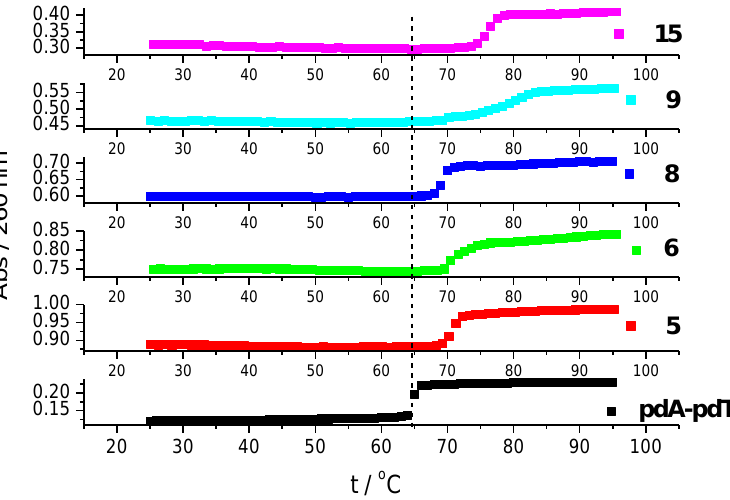
Figure 2. Melting curve of poly dA-poly dT upon addition of ratio, r ([com- pound]/[polynucleotide]) = 0.3 of 5, 6, 8, 9 and 15 at pH = 7.0 (buffer sodium cacodylate, I = 0.05 mol dm −3 ).